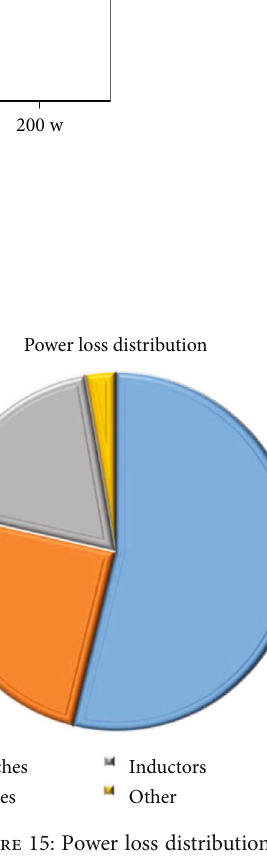
Figure 15: Power loss